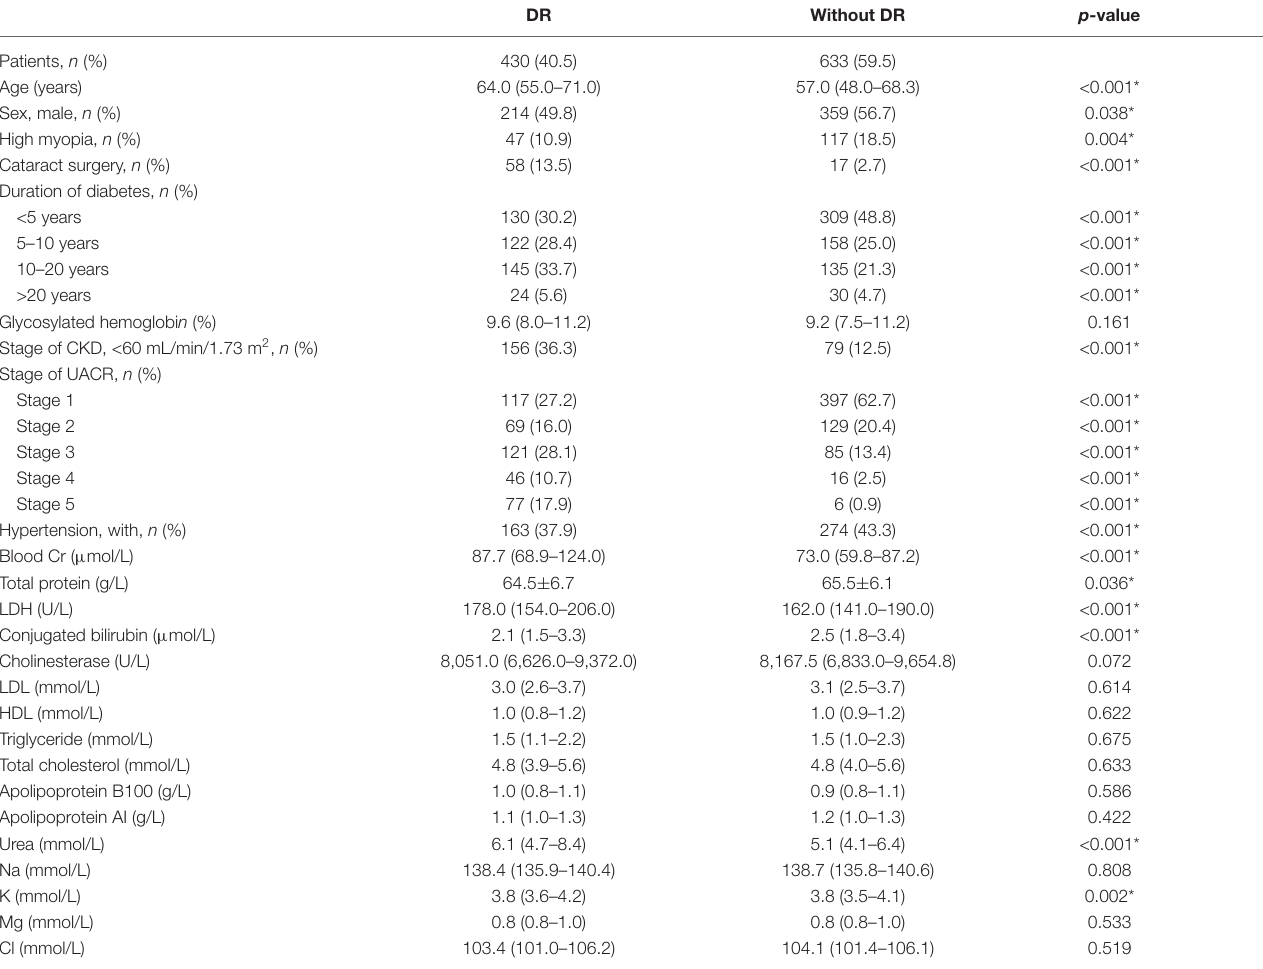
TABLE 1 | Characteristics and differences between DR and without DR patients.